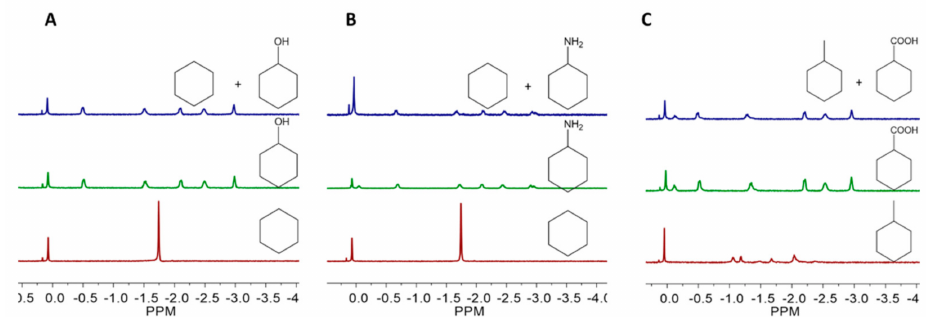
Figure 2. Partial comparative 1 H NMR spectra of cavitand 1 upon adding from bottom to top ( A ): cyclohexane, cyclohexanol, mixture of cyclohexane and cyclohexanol, ( B ): cyclohexane, cyclohexy- lamine, mixture of cyclohexane and cyclohexylamine, ( C ): methylcyclohexane, cyclohexanecarboxylic acid, mixture of methylcyclohexane and cyclohexanecarboxylic